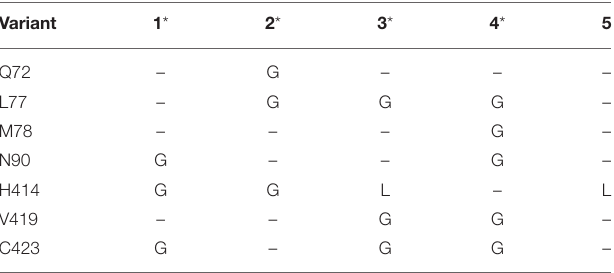
TABLE 1 | Top five variants of CS1, sorted by interaction energy between the enzyme and unmodified cofactor F 430 .